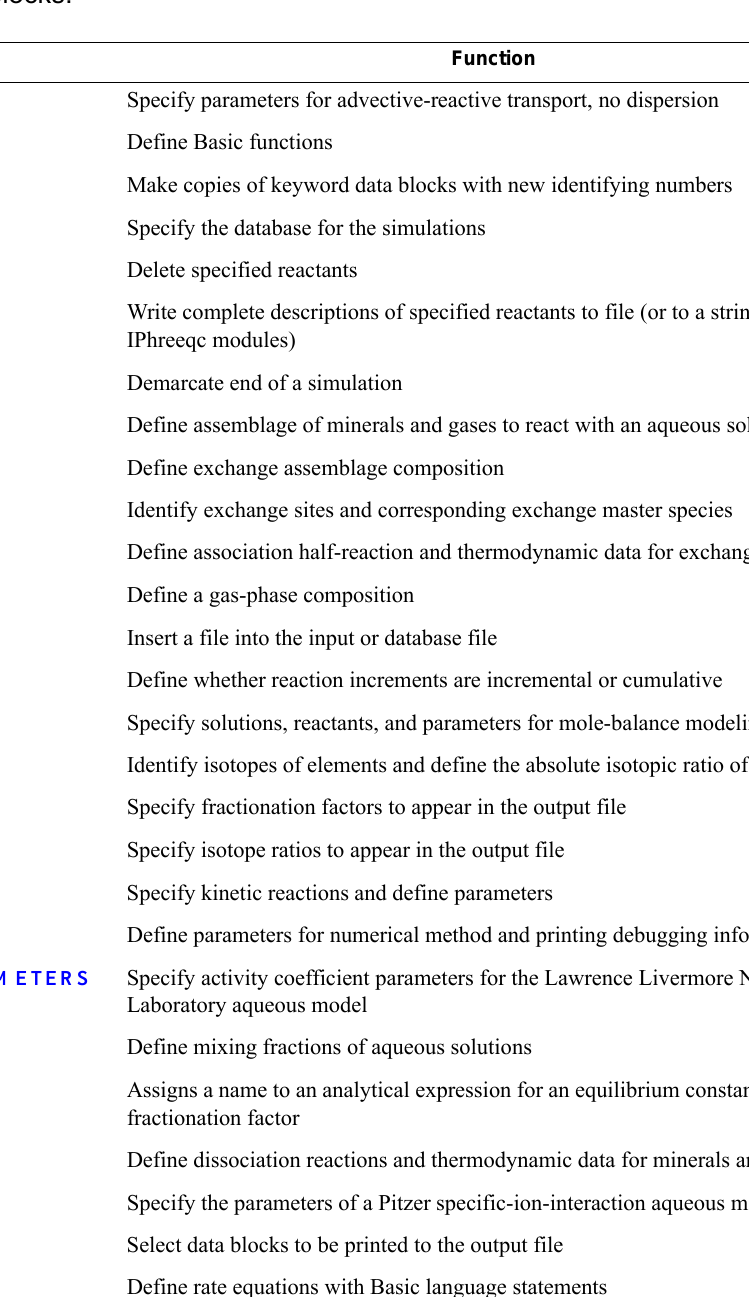
Table 1. List of keyword data